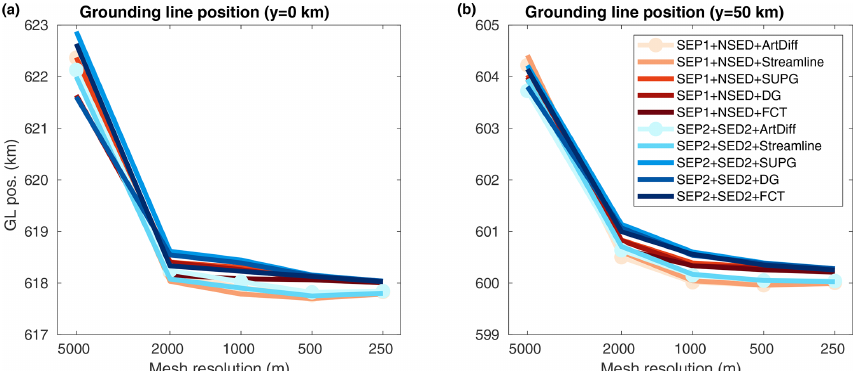
Figure 14. Basal friction perturbation experiment: convergence of grounding line positions at the end of the experiment ( t = 100 years) for y = 0 (a) and y = 50km (b) . Different stabilization schemes and two sets of sub-element parameterizations are employed (see